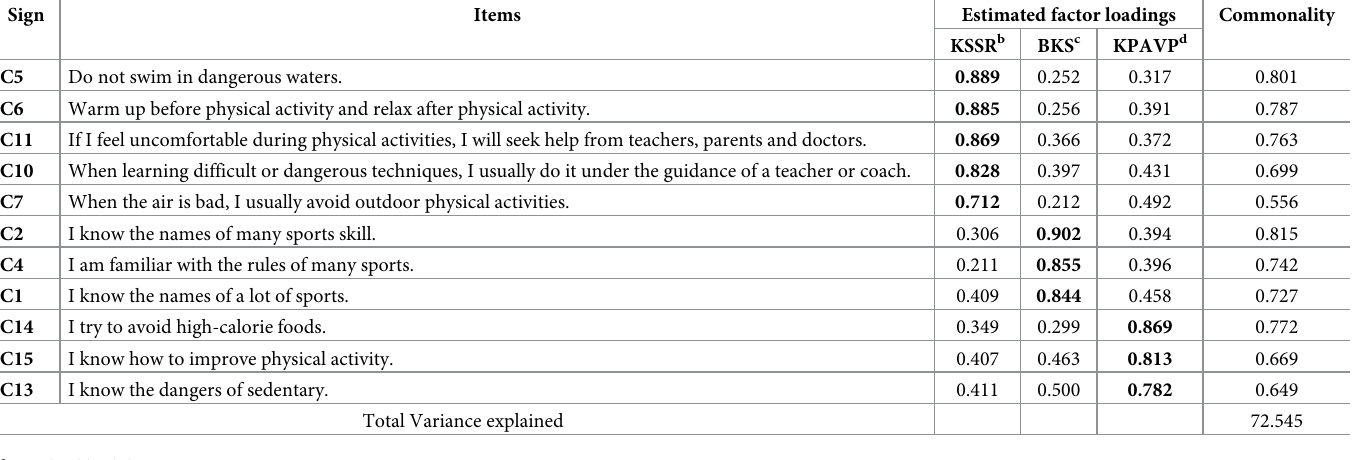
Table 9. Factor structures of knowledge and understanding by exploratory factor analysis a . Sign